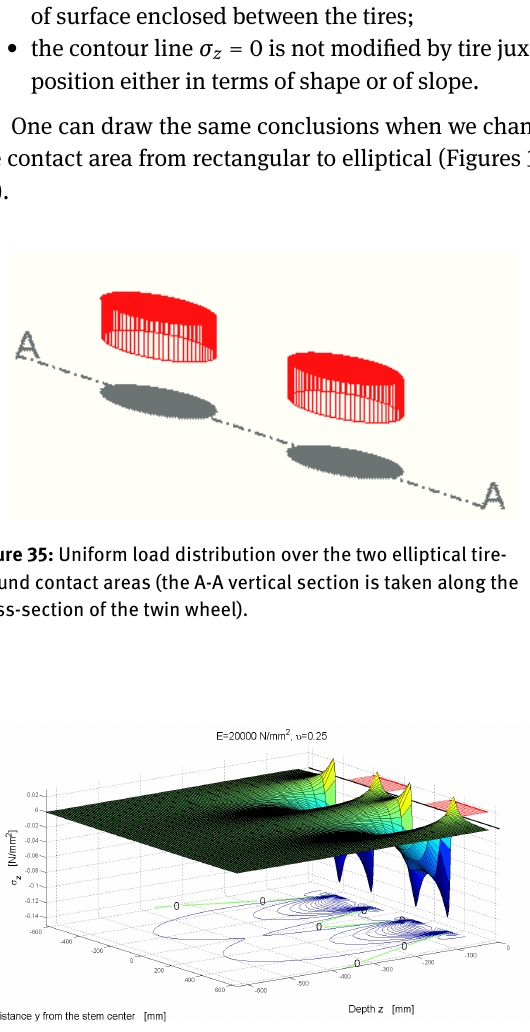
Figure 36: 3-D surface and stress contours of on the A-A vertical cross-section of Figure 35 (second order solution).